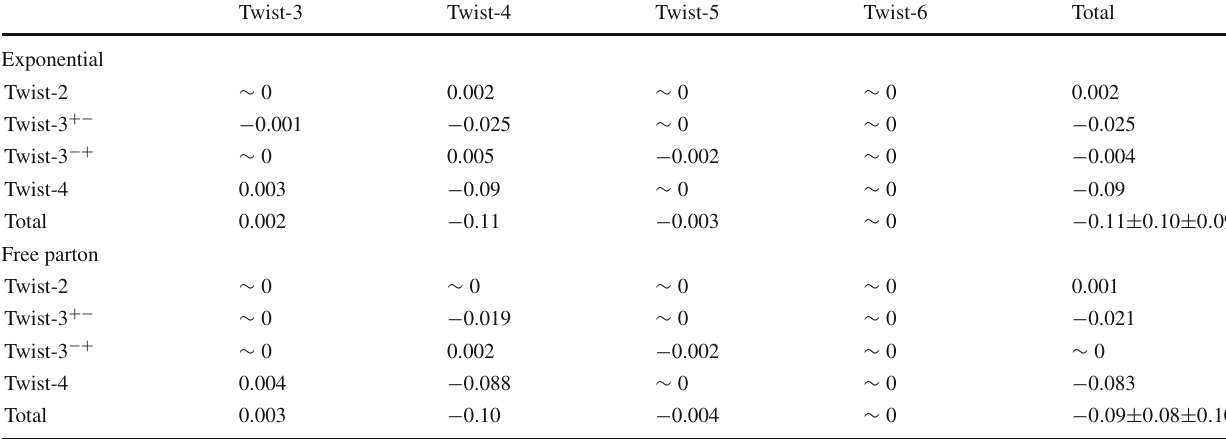
Table 11 The same as Table 4 but for form factor g 3 ( 0 ) in unit of 10 −